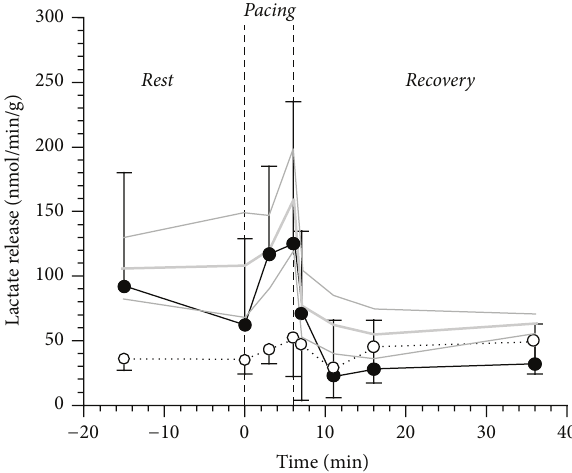
Figure 4: Cardiac lactate release as estimated subtracting [3- 13 C]- L-lactate cardiac uptake to the natural substrate net balance in 5 N- AGT (gray line), 4 DCM-NGT (dotted black line), and 4 DCM-AGT (continuous black line) in the 3 phases of the study protocol: Rest , Pacing , and Recovery . The plotted values are mean ± SEM. The thin gray lines represent the SEM of the N-AGT